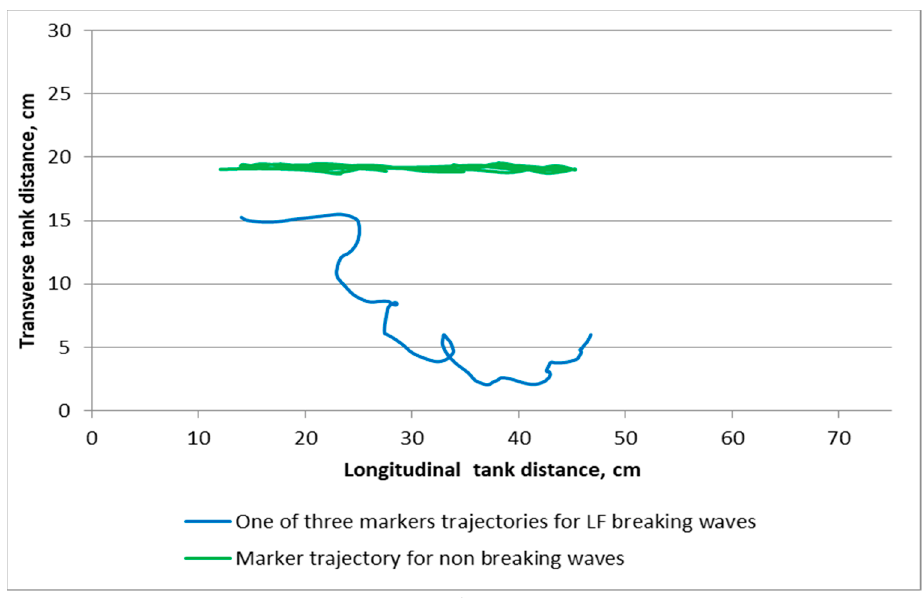
Figure 5. An image of the water surface with trajectories of three surface markers after LF wave breaking ( a ), and marker trajectories for both breaking and non-breaking LF waves (blue and green curves, respectively) ( b ). Wave propagating is from left to right. The duration of video is 10 s.